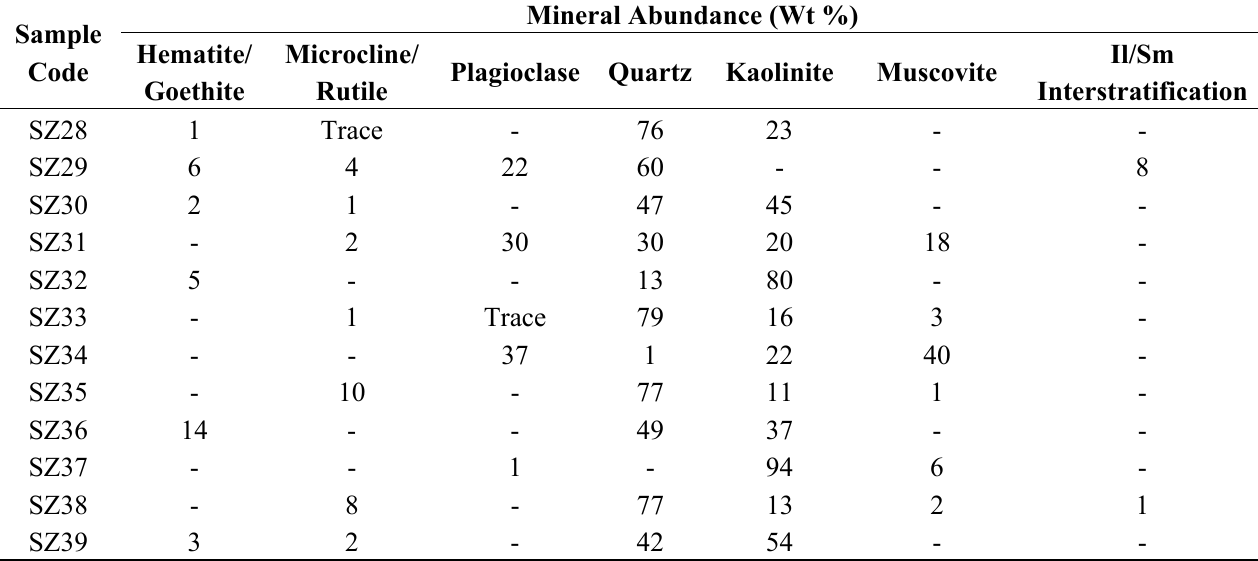
Table 4. Mineral assemblage of soil samples from Swaziland.